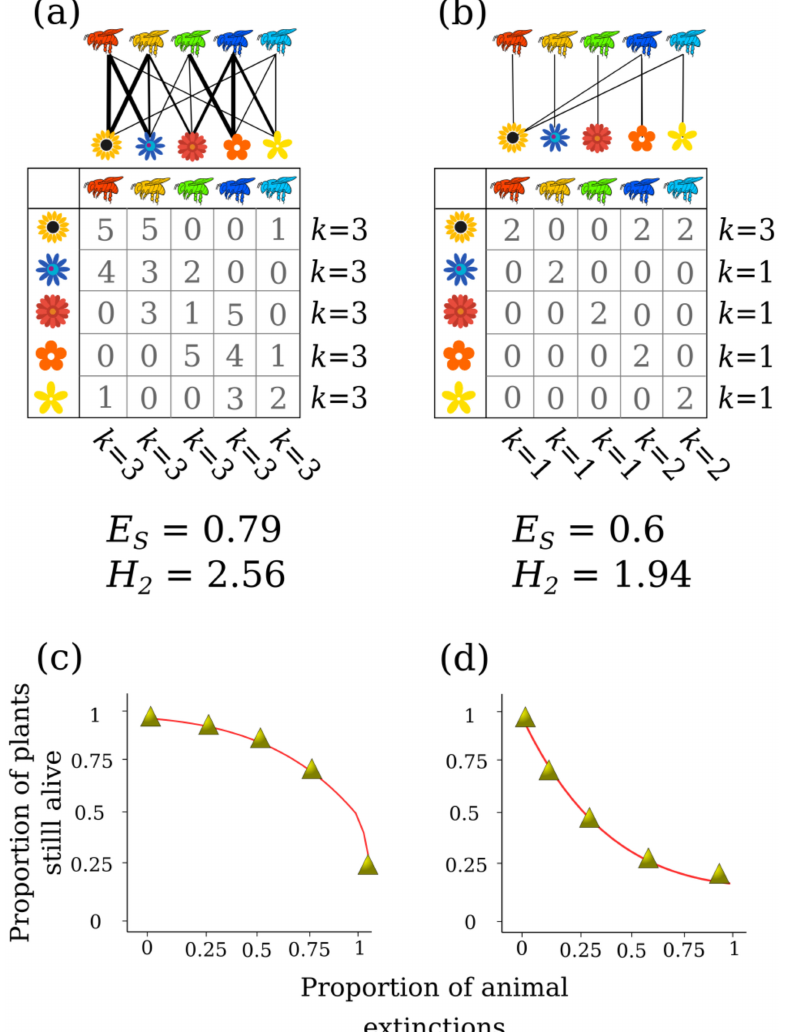
Figure 2. ( a ) A network with an equal number of links per species k (i.e., degree), which reflects a higher evenness but with high internal heterogeneity, as all species establish di ff erent numbers of interaction frequencies. ( b ) A network with di ff erent numbers of links per species, which reflects a lower interaction evenness but with homogeneous interaction frequencies per species. Each dimension of the matrices represents just one trophic level (e.g., rows = plants; columns = pollinators). Interaction evenness is represented by E S and interaction diversity by H 2 . ( c ) Simulated random extinction of plant species in a network, the area below the curve represents the robustness of the network (i.e., higher robustness to species extinction). ( d ) Simulated extinction of the most connected plant species to the least connected; the area below the curve represents the robustness of the network (i.e., lower robustness to species